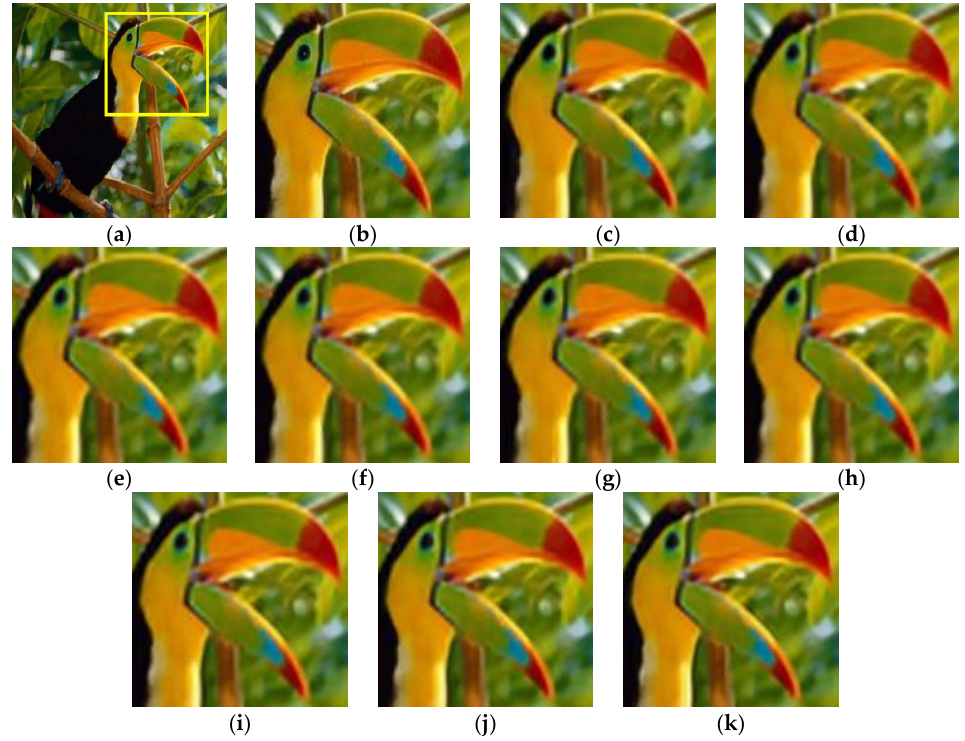
Figure 8. Comparison of the reconstructed images with different SR algorithms for Bird . ( a ) Bird; ( b )